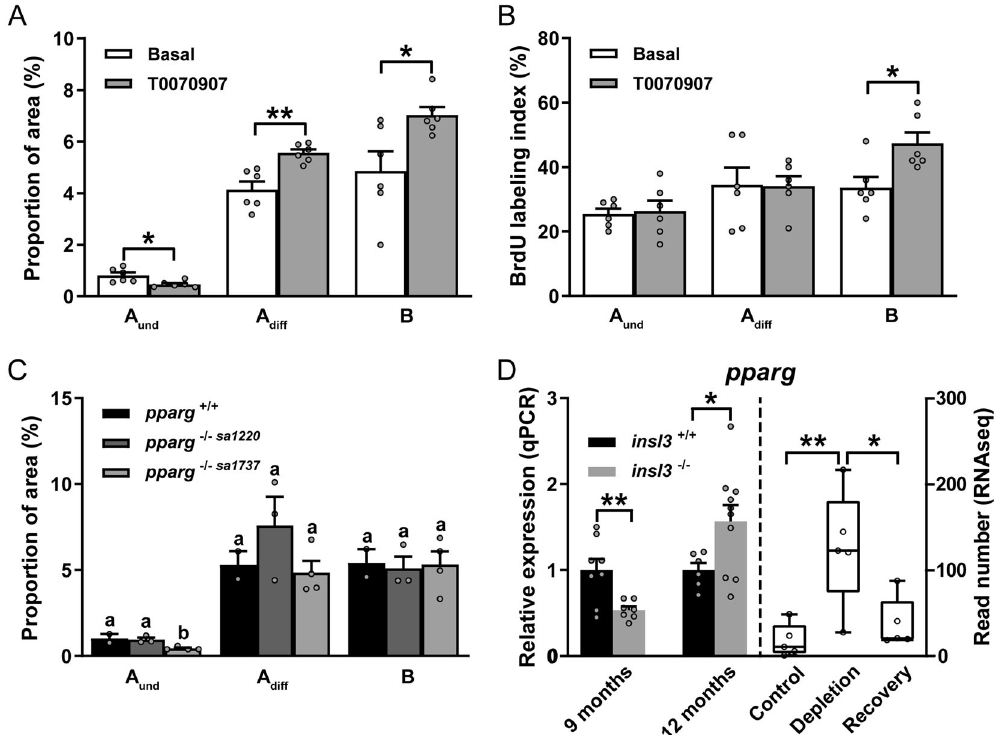
Fig. 6 Pparg involvement in Insl3-induced spermatogenesis. A , B Evaluation of the proportions ( A ) and of the proliferation activity of spermatogonia ( B ) in zebra fi sh testes cultured for 4 days in the absence or presence of the Pparg antagonist T0070907 (10 μ M). C Area occupied by different types of spermatogonia in wild-type ( pparg + / + ) and pparg knockout ( pparg − / − ) adult testes. Two different pparg -/- mutants (alleles 1220 and 1737) were evaluated. D In vivo pparg expression levels in wild-type ( insl3 + / + ) and insl3 knockout ( insl3 -/- ) testes 9 and 12 months post-fertilization (left panel), and in control, germ cell-depleted (by exposure to the cytostatic agent busulfan 51 ), and testes with recovering (from busulfan) spermatogenesis, as described by Crespo et al. 25 (NCBI GEO data set GSE116611) (right panel). In A – C and right panel in D , data are shown as mean ± SEM ( A , B : N = 6; C : pparg + / + , pparg − / − sa1220 and pparg − / − sa1737 , N = 2, 3 and 4; D : N = 5; * p < 0.05; ** p < 0.01), and in the left panel in D as mean fold change ± SEM ( insl3 + / + and insl3 − / − , 9 months: N = 8 and 7; insl3 + / + and insl3 − / − , 12 months: N = 6 and 10; * p < 0.05; ** p < 0.01) and expressed relative to the control group (which is set at 1). In C , different letters indicate signi fi cant differences between groups (* p < 0.05). A und , type A undifferentiated spermatogonia; A diff , type A differentiating spermatogonia; B, type B